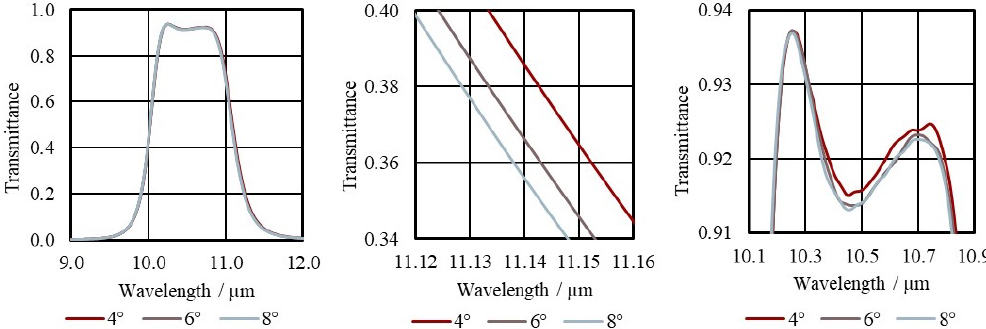
Figure 8. Filter transmittance measured with FTS of a filter with its bandpass at about 10.6µm for the investigation of the influence of different tilt angles on the spectral transmittance. The standard angle used during the calibrations is 6 ◦ . Shown is the same measurement in different wavelength